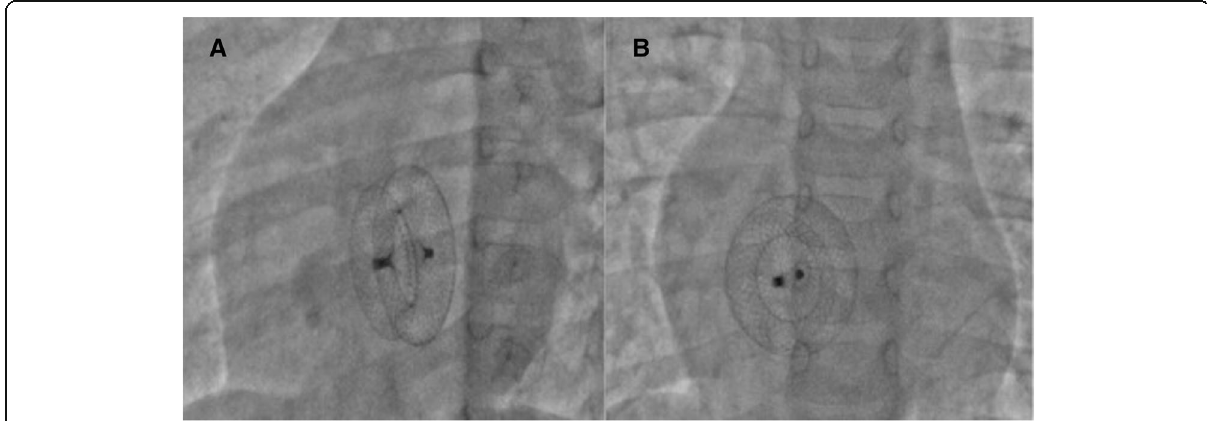
Fig. 7 Final fluoroscopy images after the release of ASD closure device from the snare in left anterior oblique 45° ( A ) and anteroposterior views ( B ) confirming the proper positioning of the device across the